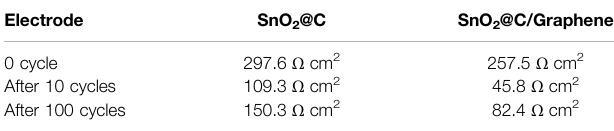
Figure 12 represent the CV of SnO